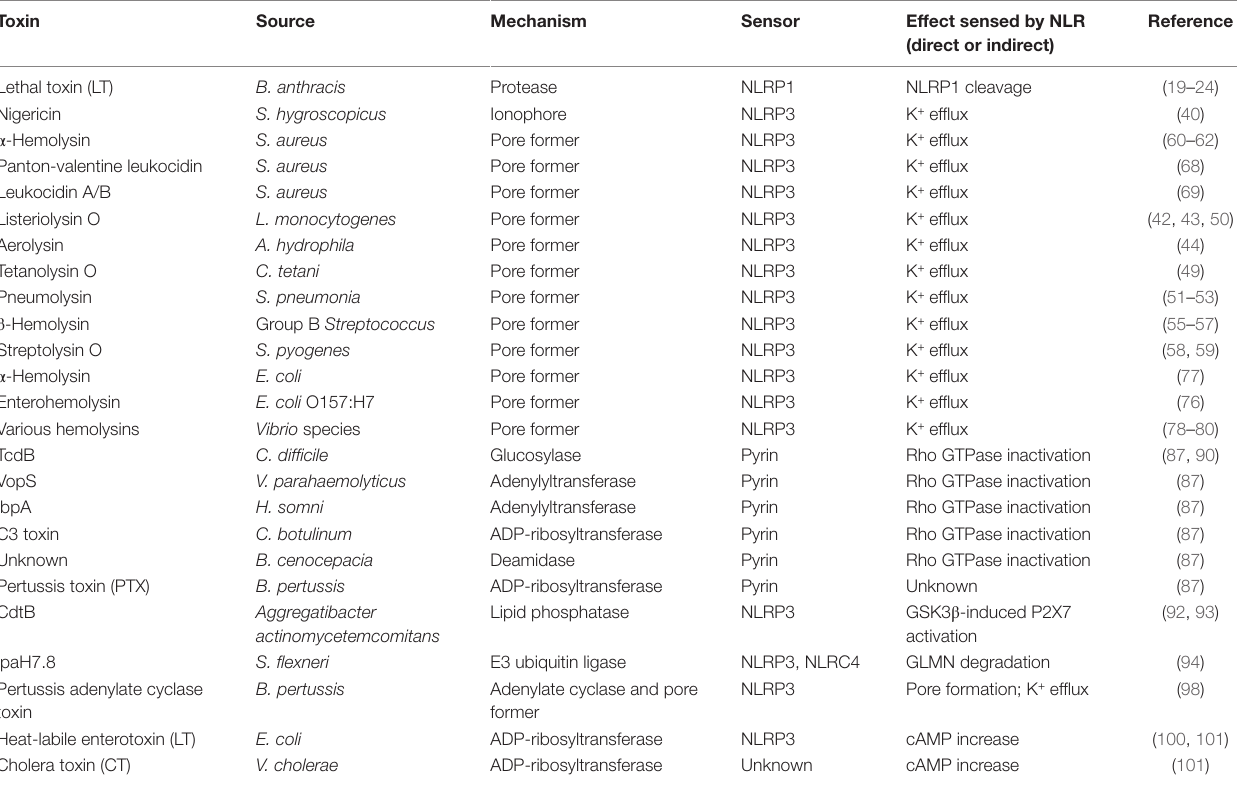
TABLe 1 | inflammasome-activating bacterial